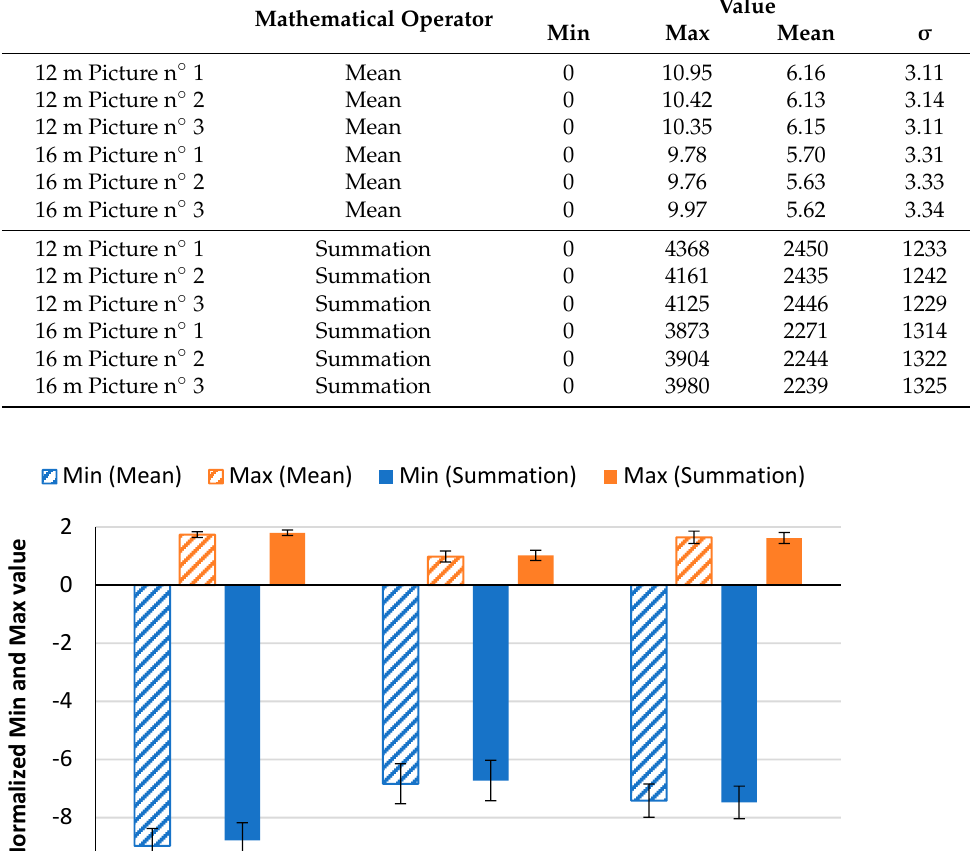
Table 3. Description of VSI A results for each image (including crops and soil).